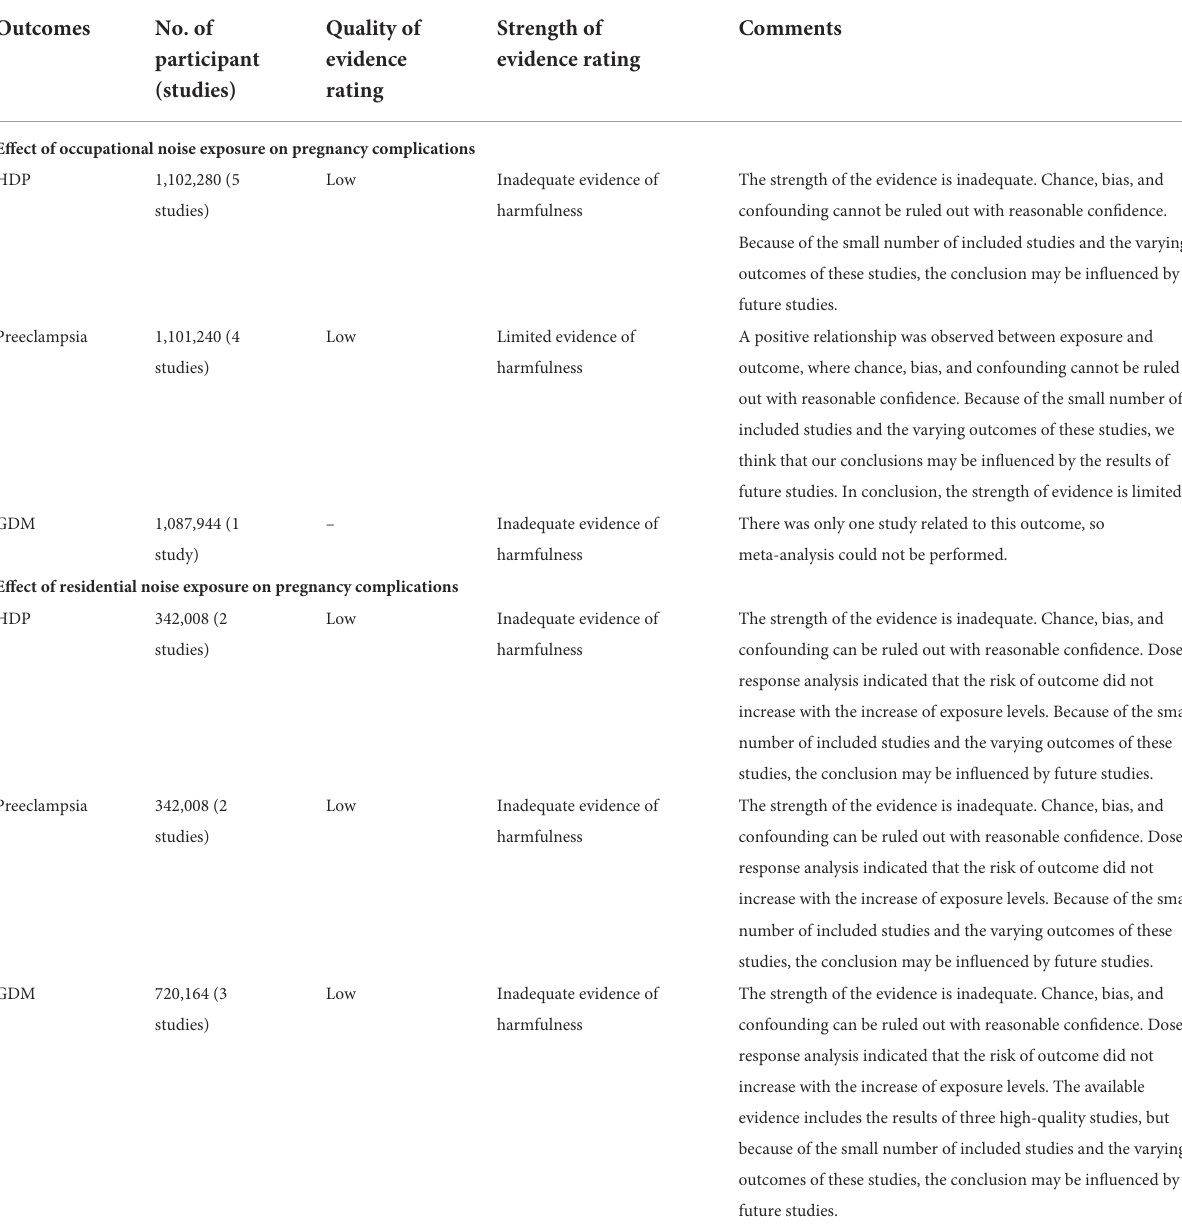
TABLE 2 Summary of findings, quality of evidence, and strength of evidence for noise exposure during pregnancy and pregnancy